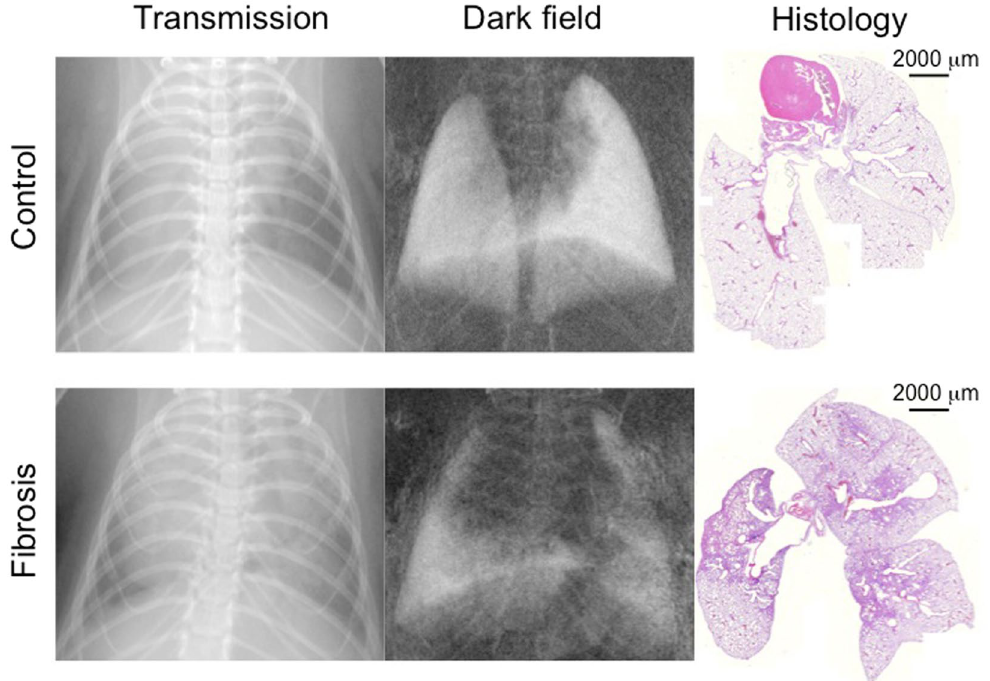
Figure 1. Dark-field and transmission images of fibrotic and healthy murine lungs. Representative pictures of a transmission image (left) and dark-field image (middle) of a healthy (upper row) and fibrotic lung (lower row). Histology (right) serves as the gold